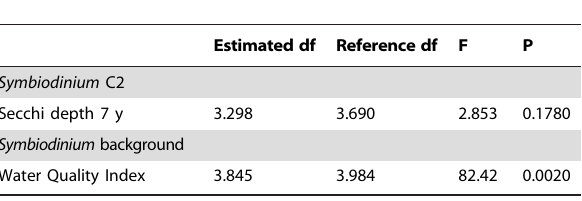
Table 6. Summary of GAMs to examine the environmental drivers associated with the distribution of the dominant Symbiodinium type sampled in the Whitsunday Islands.